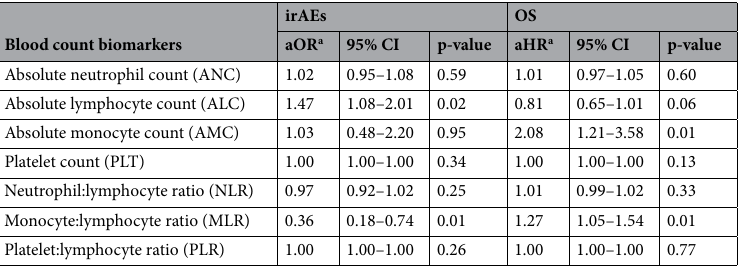
Table 3. Association of blood count biomarkers as continuous variables with irAEs and OS. a Adjusted for age, sex, smoking history, cancer type (hematological malignancy vs solid tumor), ECOG PS, concomitant other systemic therapy, personal or family history of autoimmune disease, personal history of chronic infection, systemic steroid treatment at time of ICI initiation.